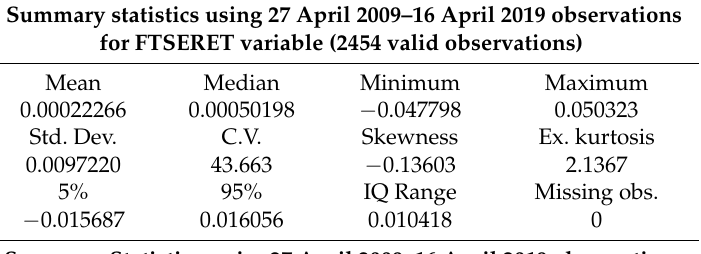
Table 1. Summary Statistics of FTSE Continuously Compounded Returns and RV5.